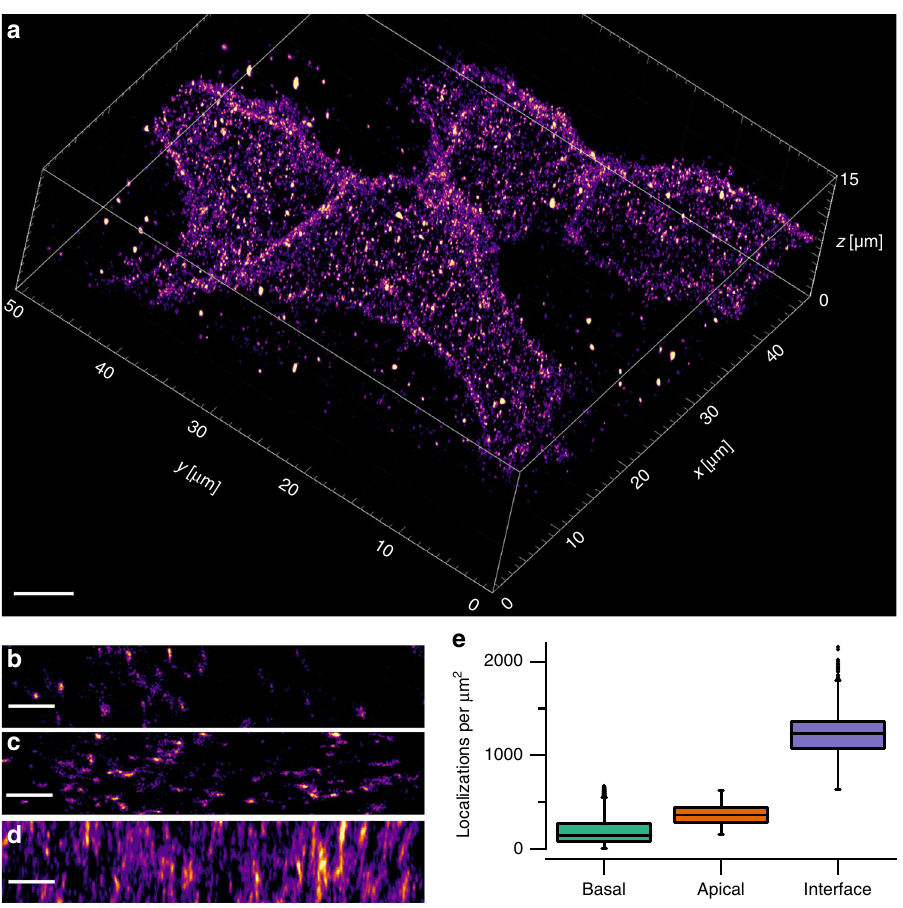
Fig. 1 Visualizing the distribution of CD56 receptors in the plasma membrane of fi xed whole 293T cells by 3D-LLS- d STORM. a Reconstructed volume rendering of single-molecule localizations shows considerable accumulation of CD56 receptors at cell – cell interfaces between the three cells. Representative 2D xy -projections of small areas of the basal ( b ) and apical ( c ) plasma membrane. Representative 2D projection perpendicular to the z -axis highlighting the increased CD56 density and the cell – cell interface ( d ). Note the lower spatial resolution in z -direction. e Localization densities (median ± MAD) measured at the basal (139 ± 76 localizations/ µ m 2 ) and apical plasma membrane (361 ± 79 localizations/ µ m 2 ), and at the cell – cell interface (1234 ± 146 localizations/ µ m 2 ) for the shown cell. Boxplot of n = 7201 (basal), n = 854 (apical), and n = 628 (interface) sliding window data points. Boxplots show median (center line), 25th and 75th percentile (box), and 1.5× interquartile range (whiskers). Scale bars, 5 µ m ( a ), 1 µ m ( b – d